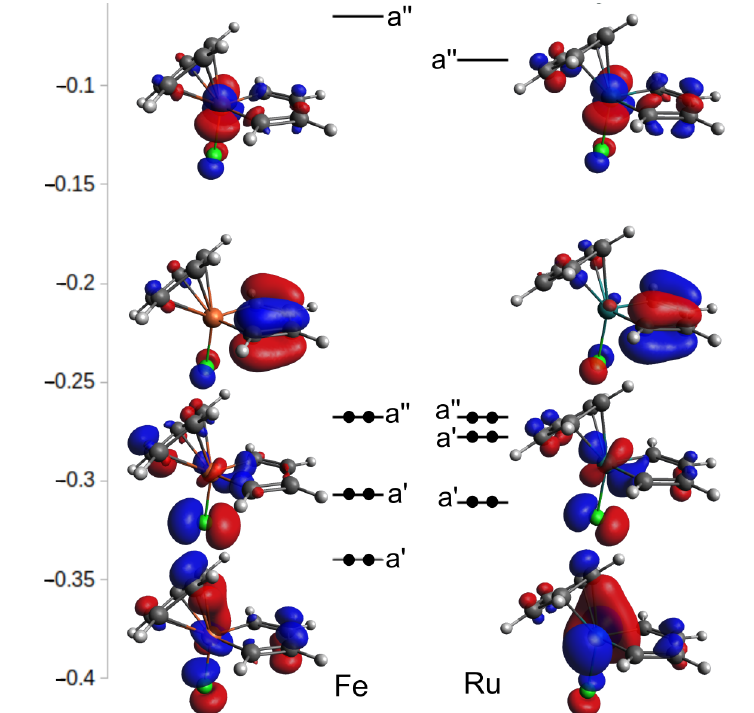
Figure 2. Frontier MO and their energies of complexes 5 and 6 . Energy in